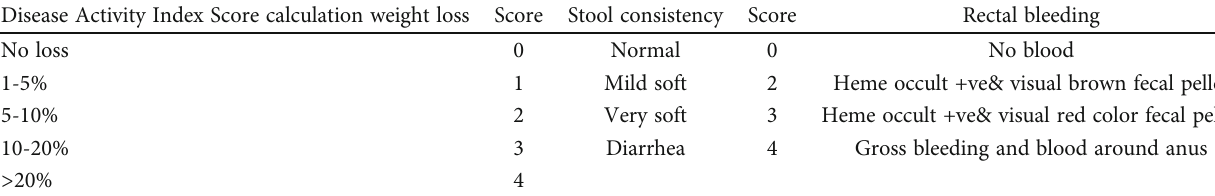
Table 1: Disease Activity Index